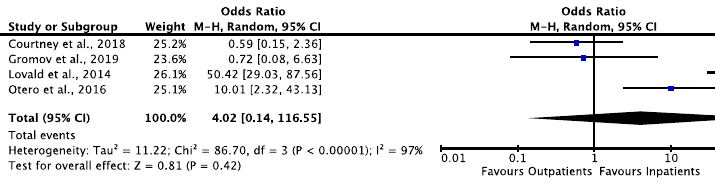
Figure 3. Cont Forest plot of the comparison: Mortality